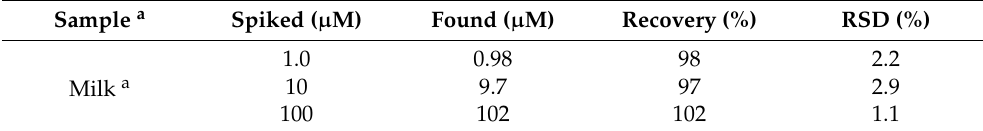
Table 2. Determination of H 2 O 2 in milk. Sample a Spiked ( µ M) Found ( µ M) Recovery (%) Milk